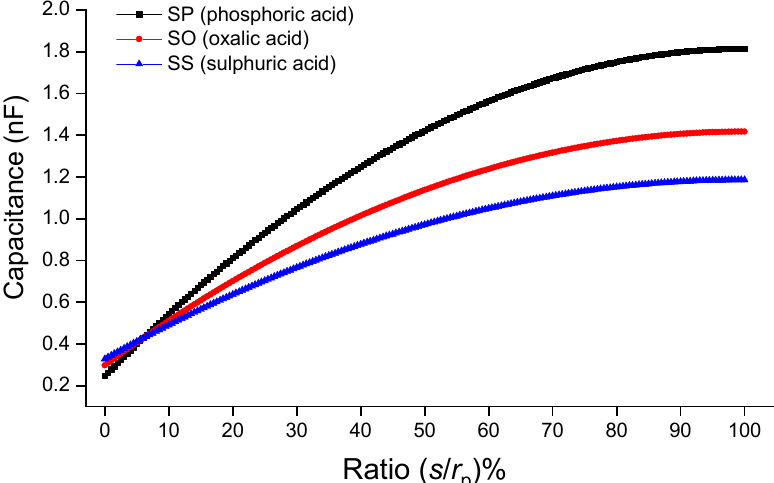
Figure 9. Simulation results for the capacitive response of the sensors with the variation of humidity condensation inside the pores.